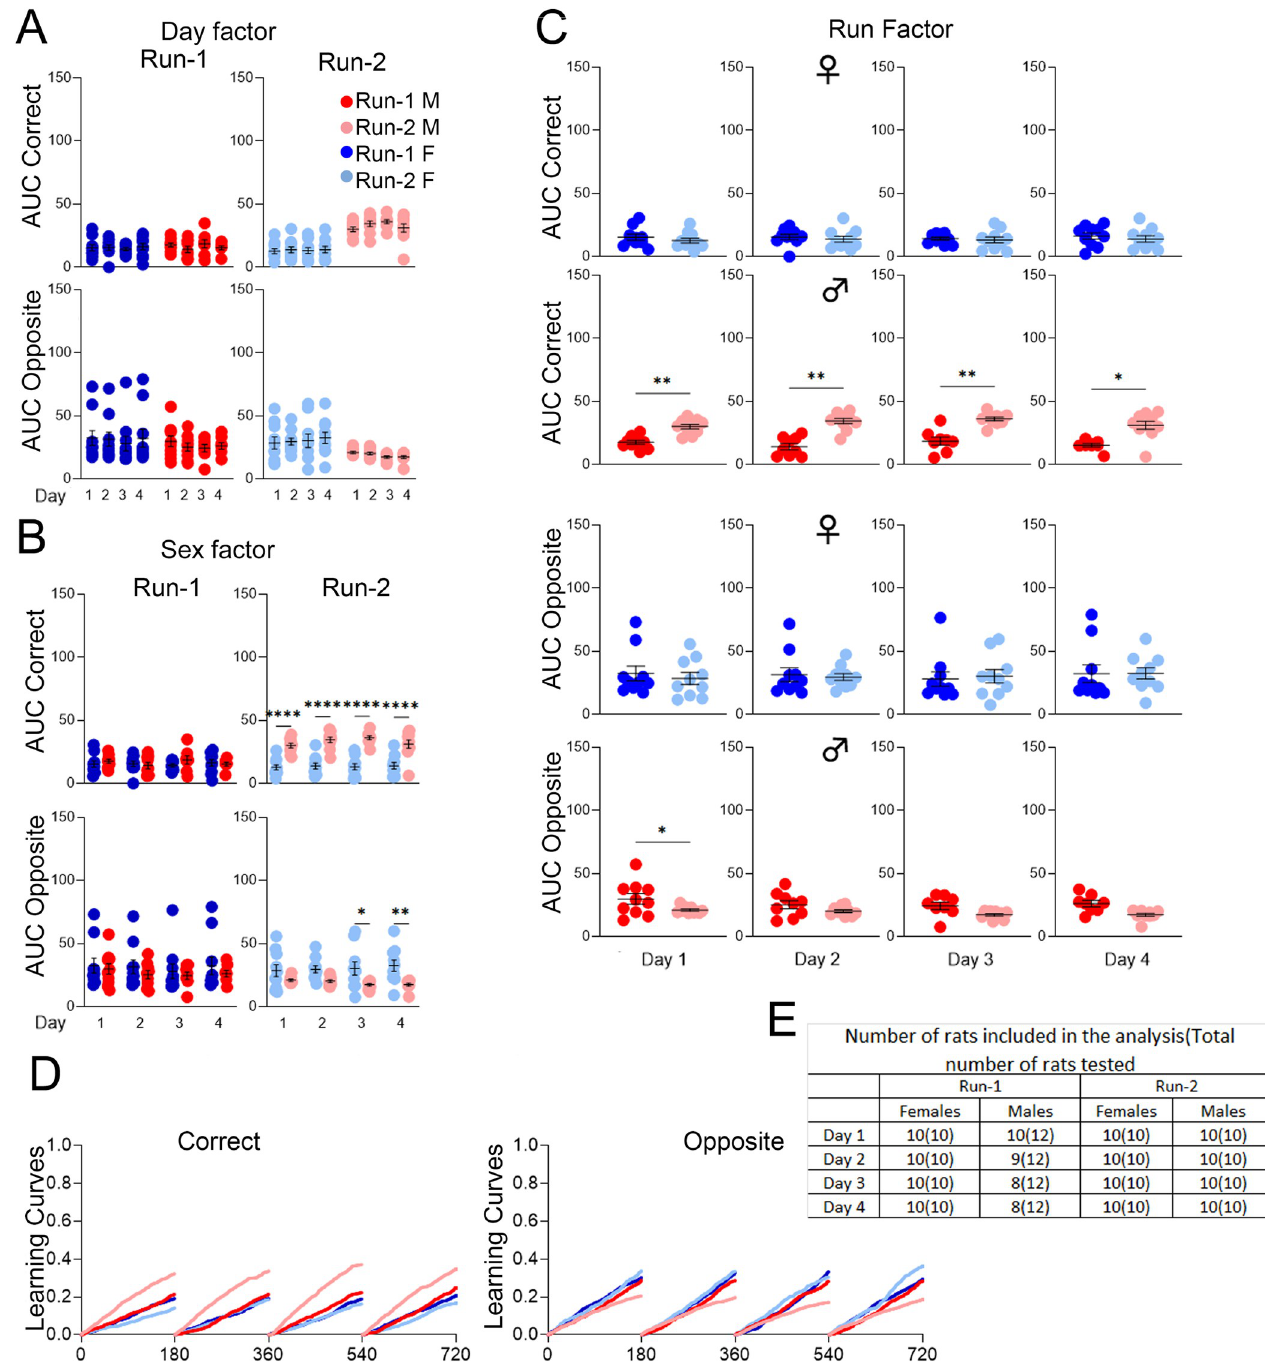
Fig 10. Serial reversal, cohort B. (A) Day factor, (B) Sex factor and (C) Run factor comparisons of area under the curve (AUC) for activity curves of individual animals by sex, program day, and Run, separated by visit categories (Correct, SR-C or Opposite, SR-O). (D) Activity curves showing the fractional accumulation (y-axis) of correct visits or opposite visits over drinking session time (x-axis), reset every 180 minutes, by sex and Run. (E) For Run-1, 12 male and 10 female rats were tested since 2 females died just before the timeline started. Two males were excluded from the analysis of day 1, three males were excluded from the analysis of day 2, and four males were excluded from the analysis of days 3 and 4 during Run-1. These animals were excluded because they visited corners less than 25 times during the drinking session. For Run-2, 10 male and 10 female rats were tested, since one male died during the time between Runs and one male died after place learning with corner switch. All 20 rats were included in the analysis of Run-2. All data represented as mean ± SEM ( � p < 0.05, �� p < 0.01, ��� p < 0.001, ���� p < 0.0001). See Tables 16 and 17 for statistical analysis. Males (M or ♂ ) are colored as red (Run-1) and light red (Run-2). Females (F or ♀ ) are colored as blue (Run-1) or light blue (Run-2).